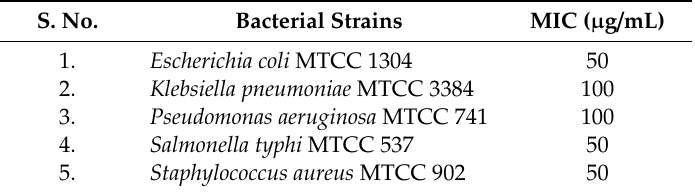
Table 2. Minimum inhibitory concentration (MIC) of ampicillin / sulbactam (Ams). S. No.